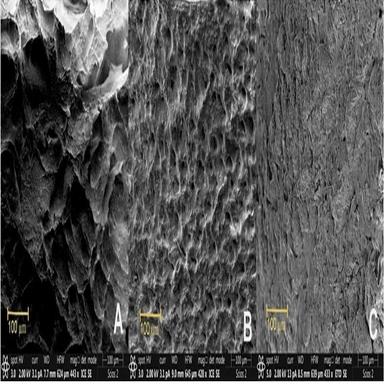
SEM images of A: Am-BIS-BT, B: HC-g-Am-1-BIS-BT and C: HC-g-Am-5-BIS-BT hydrogels.